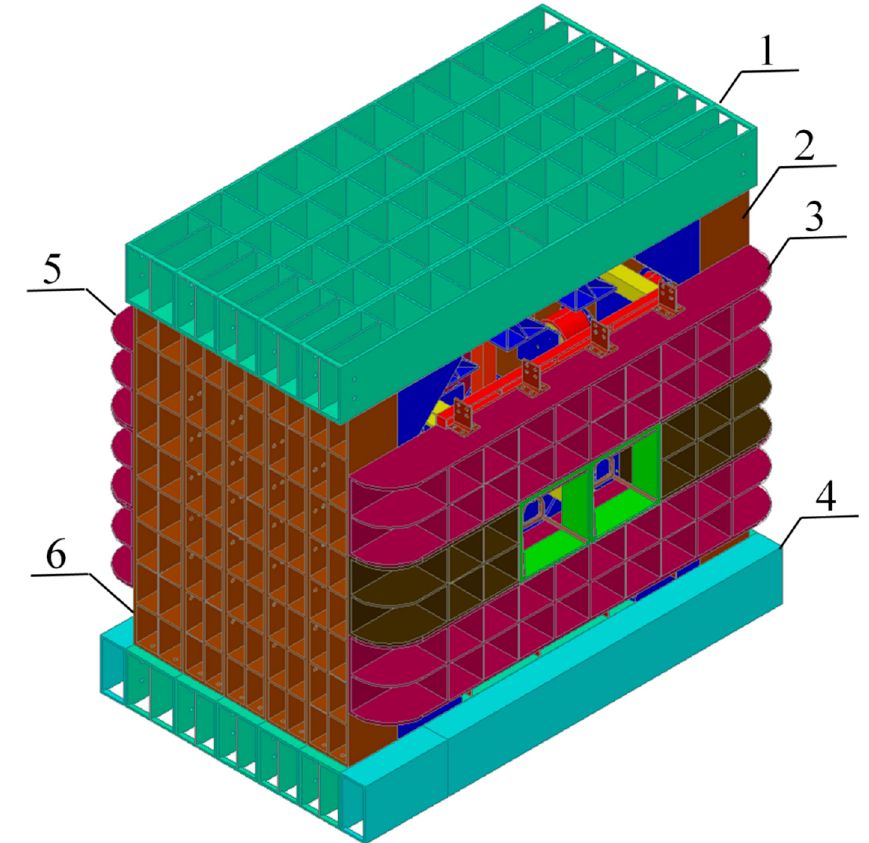
Figure 2. Three-dimensional design diagram of the combined bench counterforce device. 1: Box-type top beam; 2: box-type left upright posts; 3: box-type front counterforce wall; 4: box-type bottom beam; 5: box-type rear counterforce wall; and 6: box-type left upright posts.